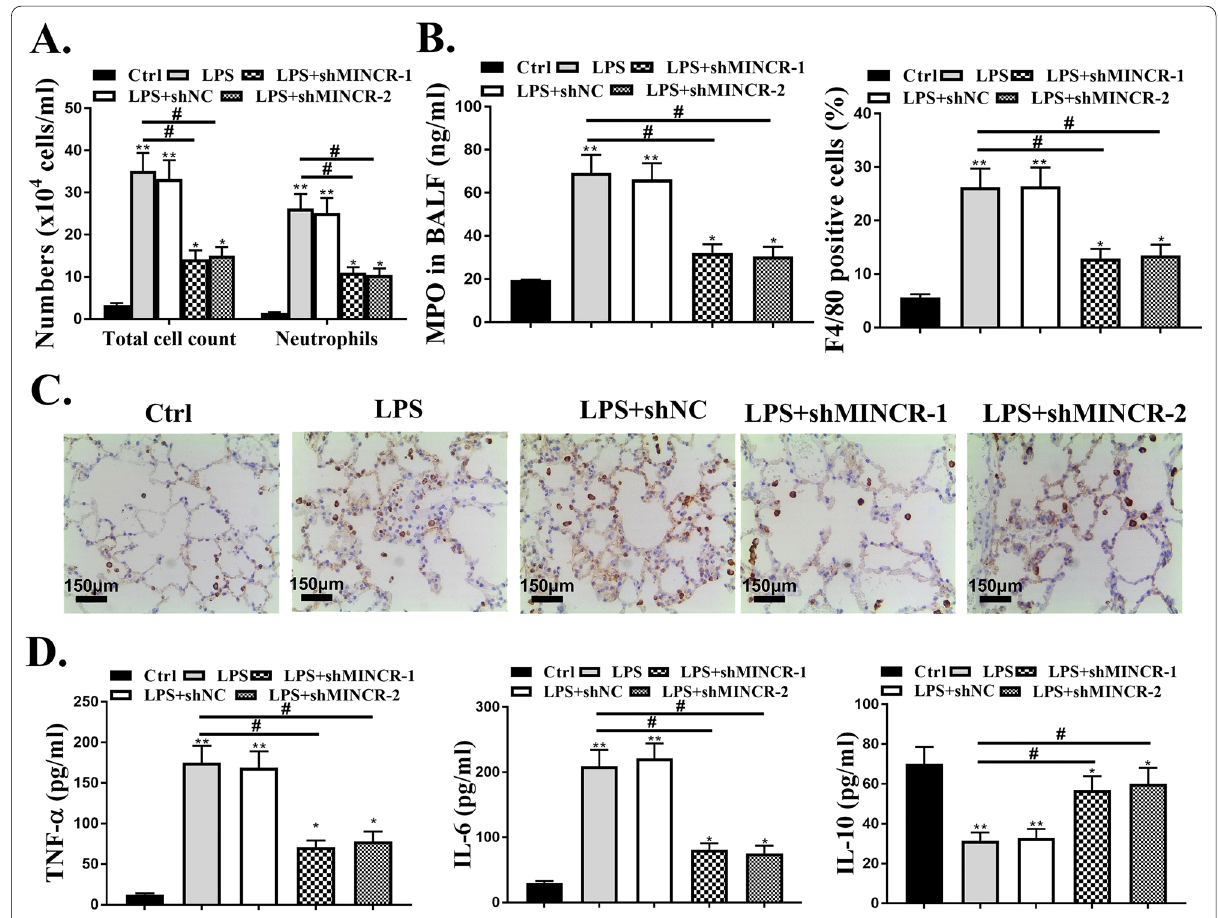
Fig. 2 Effect of MINCR on neutrophil inflammation in lungs. A quantification of total cells and neutrophils in bronchoalveolar lavage fluid (BALF) of mice. B quantification of myeloperoxidase MPO activity in BALF of mice. C F4/80 IHC. Scale bar 50 μm. D quantification of levels of TNF (tumor = necrosis factor)-α, IL (interleukin)-6, and IL-10 in BALF of mice as examined by enzyme-linked immunosorbent assay. * p < 0.05, ** p < 0.01, *** p < 0.001 vs. Ctrl group; # p < 0.05 vs. LPS. N =